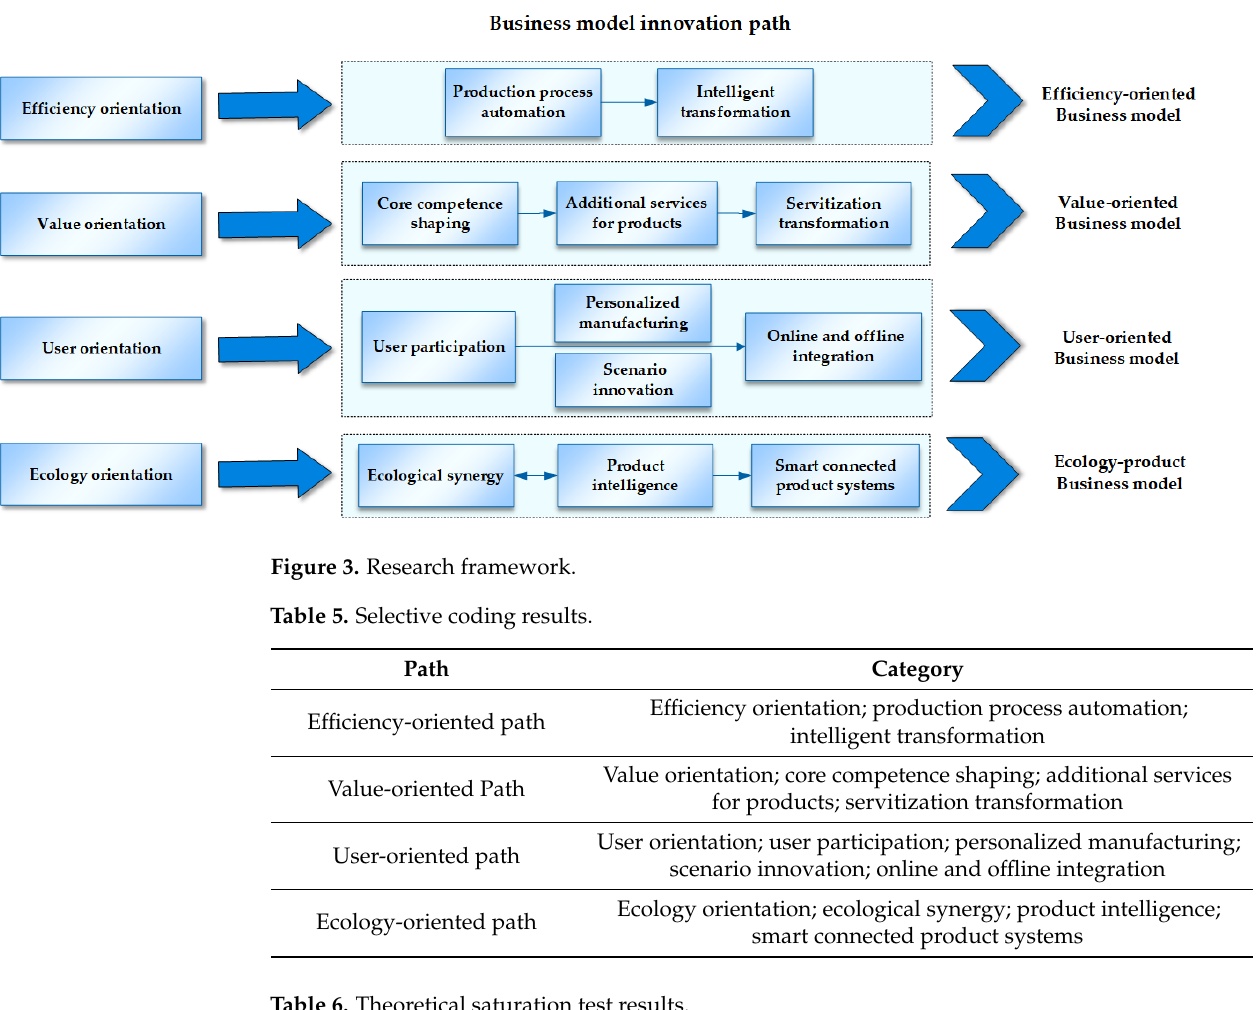
Table 6. Theoretical saturation test